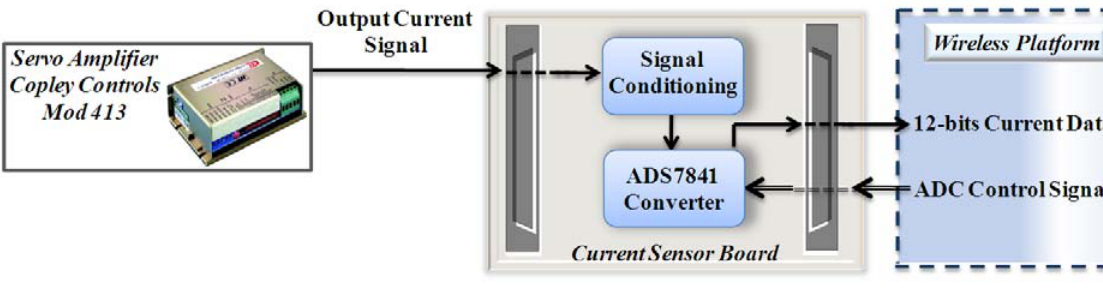
Figure 10. Block diagram for current signal instrumentation.